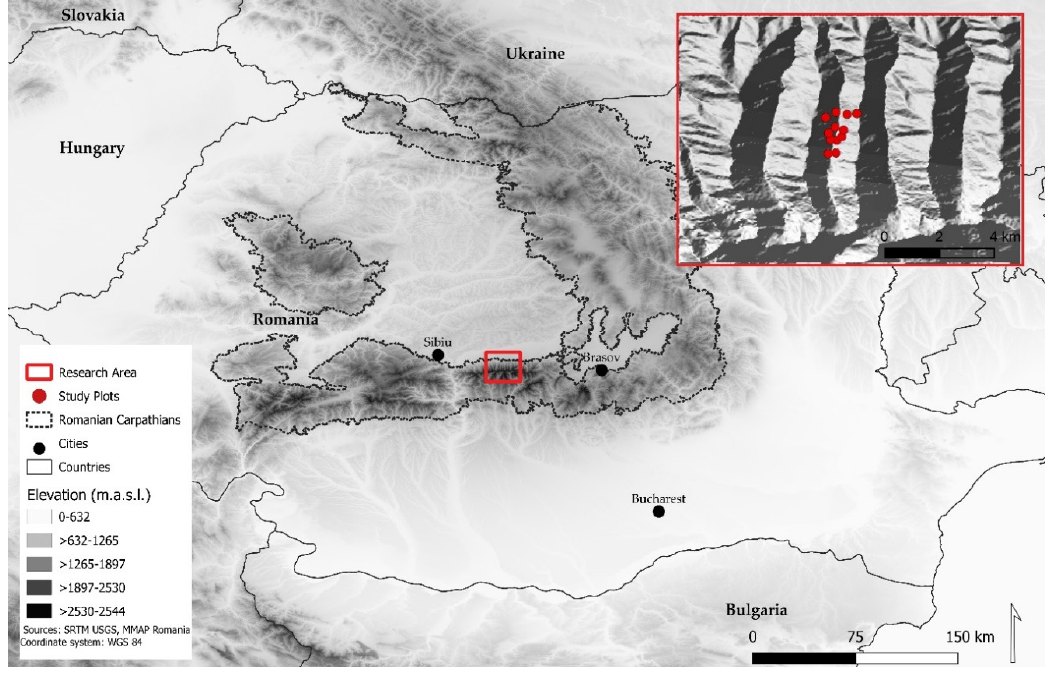
Figure 1. Study area location (European context, F ă g ă ra ș Mts., Uci ș oara Valley).[32].